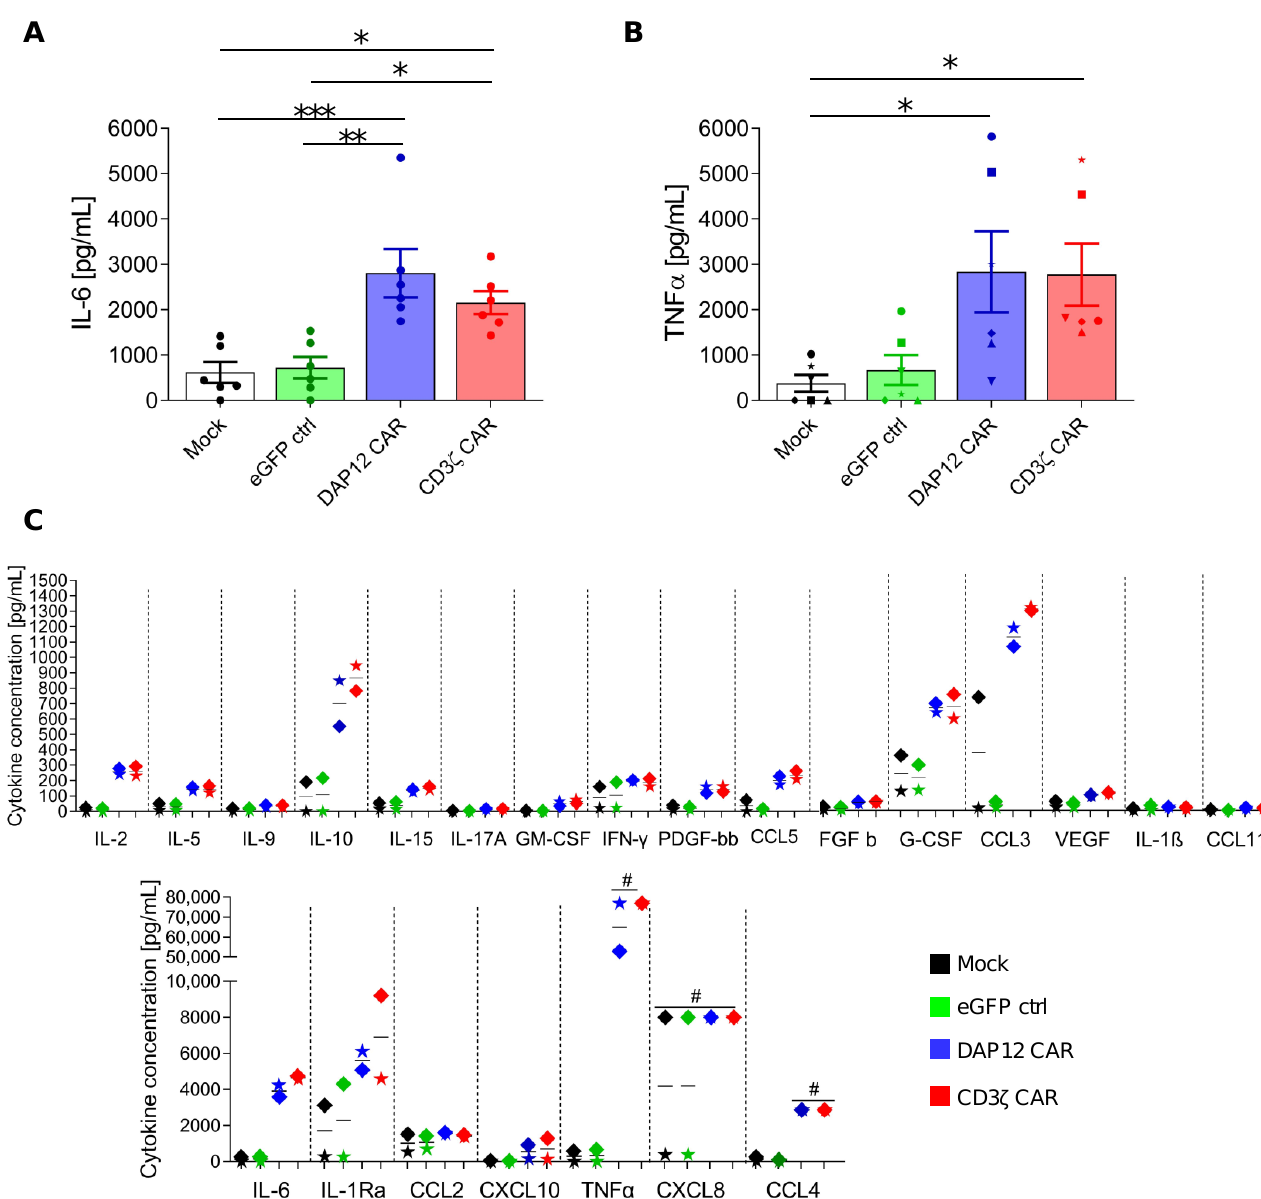
Figure 4. CAR-mediated cytokine secretion after stimulation of anti-CEA CAR M Φ s with an anti- BW431/26 idiotypic antibody. ELISA assays exhibiting ( A ) IL-6 and ( B ) TNF α secretion from M Φ s after 24 h stimulation with an immobilized anti-idiotypic antibody against the anti-CEA scFv. Data are represented as the mean ± s.e.m. of n = 6 biological replicates. Statistical significance was calculated with one-way ANOVA using multiple comparisons. ( C ) Two biological replicates (shown as colored boxes or stars) were further assessed for cytokine/chemokine production by a cytokine multiplex assay (*** indicates p < 0.001, ** indicates p < 0.01, and * indicates p < 0.03). Mock: untransduced CD34-derived M Φ s; ctrl: control; #: value measured was above detection